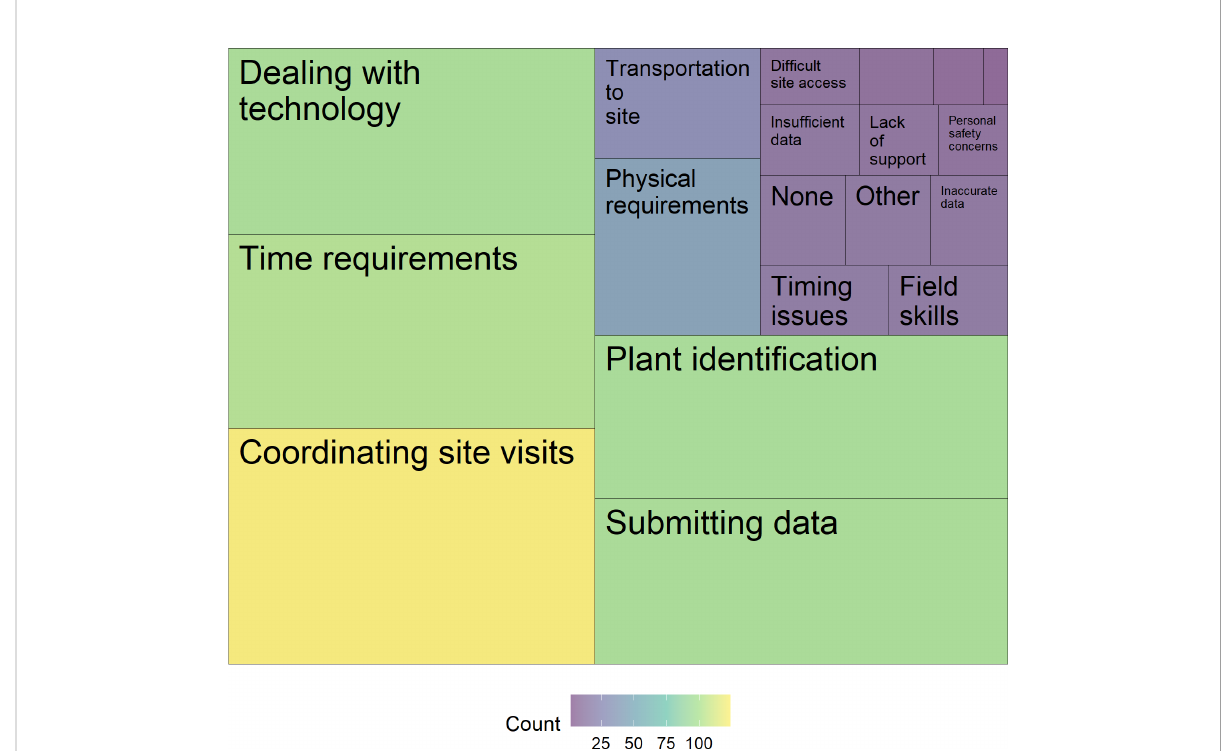
FIGURE 5 Participants ’ struggles with participating in the project scaled by count. Color ramp by count from purple (least) to yellow (most). Labels are omitted for the three struggles with the lowest counts (all <1%): site management (6), lack of monitoring opportunities (4), and COVID